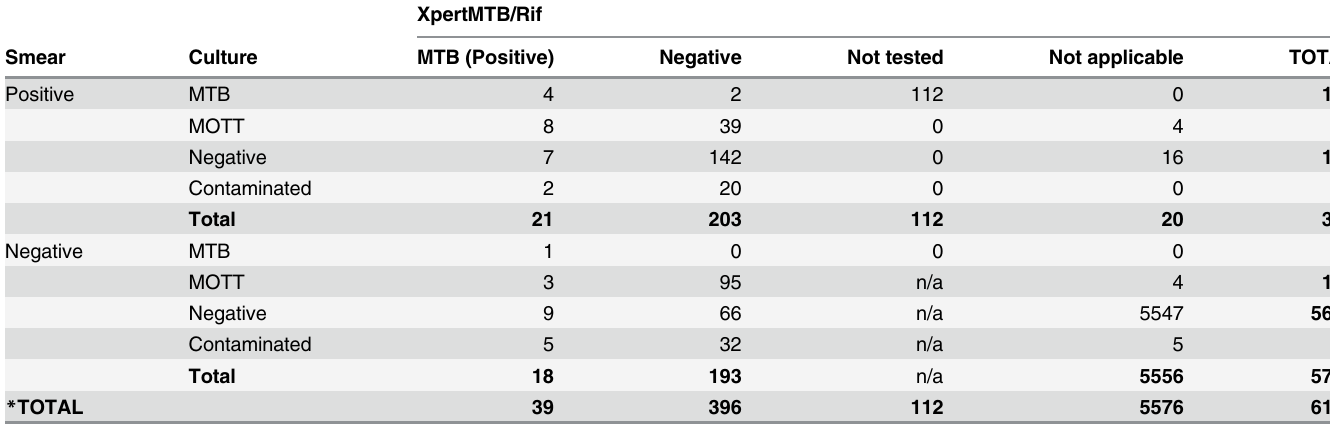
Table 1. Smear, Culture and Xpert MTB/Rif results (absolute numbers of available laboratory results).